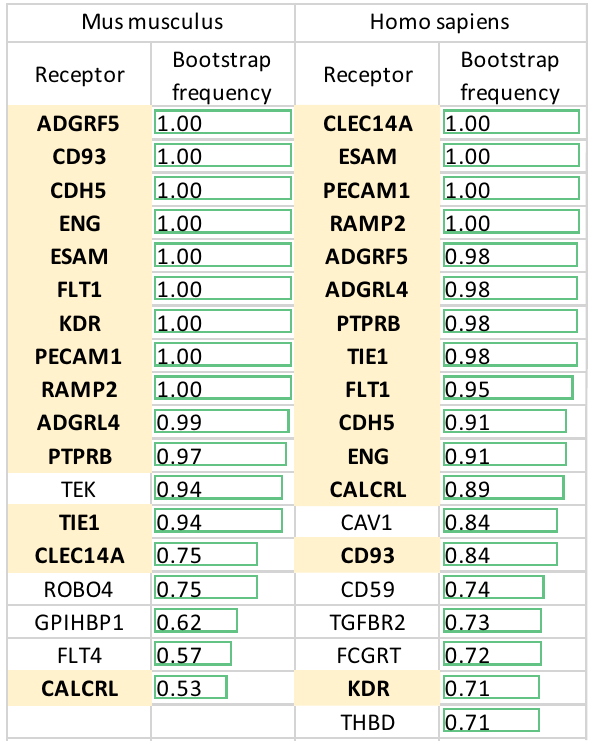
Table 1. Mouse and human naturally occurring combinations of receptors in endothelial cells are strongly conserved. Main comberon bootstrap frequencies of PanglaoDB endothelial cells annotated by DCS for Mus musculus and Homo Sapiens . Only receptors with values above 0.5 in mice (this corresponds to a p value of less 7 than 10 − ) and 0.7 in humans are shown. Receptors shown in bold with a yellow background are present in both lists and are therefore common to the main comberon of both